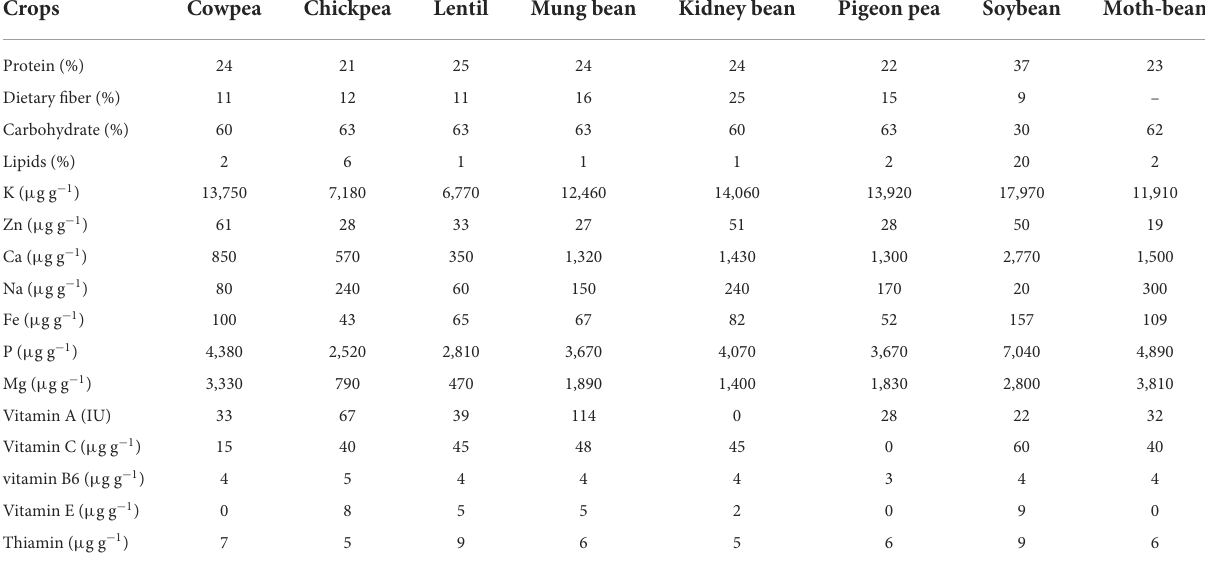
TABLE 1 Nutritional comparison among food